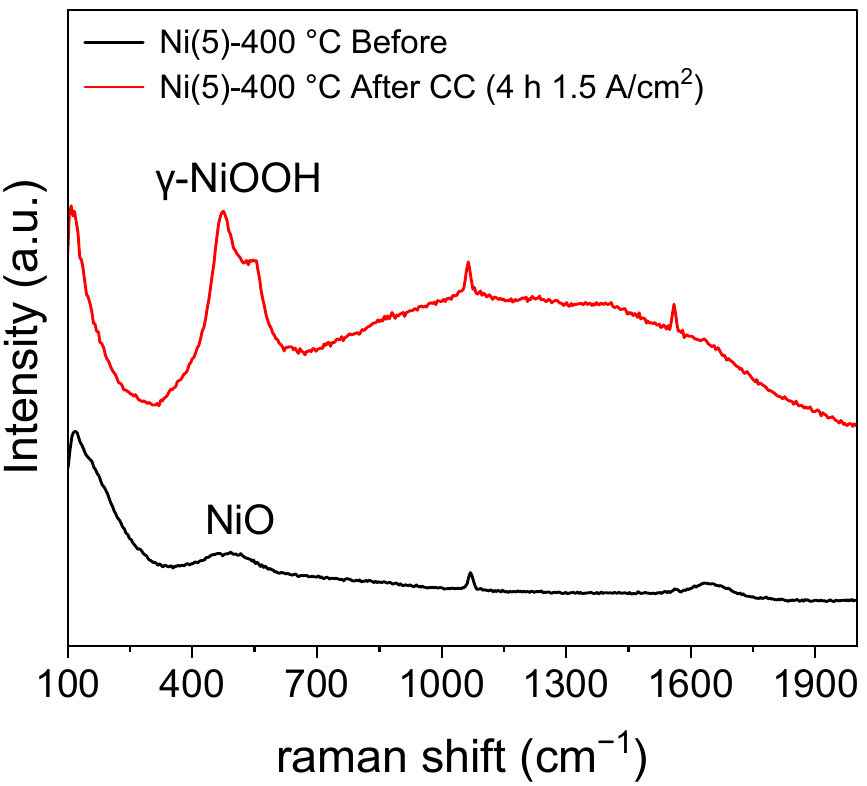
Figure 4. Raman spectra of Ni(5)-400 °C before CC (1.5 A/cm 2 ) operation and after 2 h CC operation, revealing the formation of γ -NiOOH after CC operation.